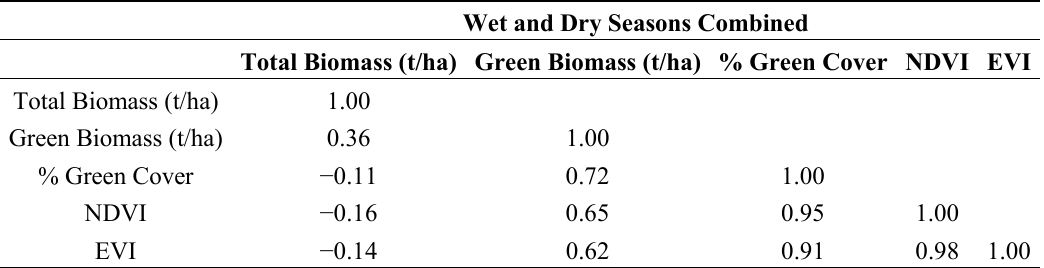
Table 2. Correlation matrix regarding the key biophysical variables evaluated in this study, simultaneously considering data from both dry- and wet-season.